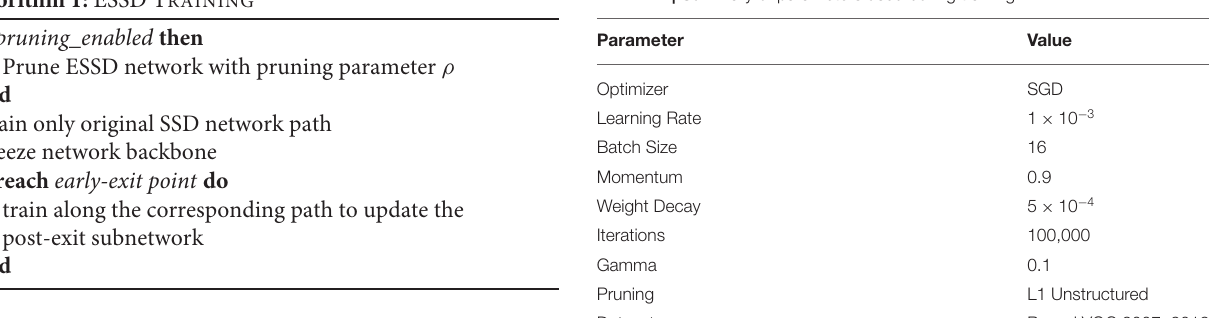
TABLE 1 | Summary of parameters used during training.